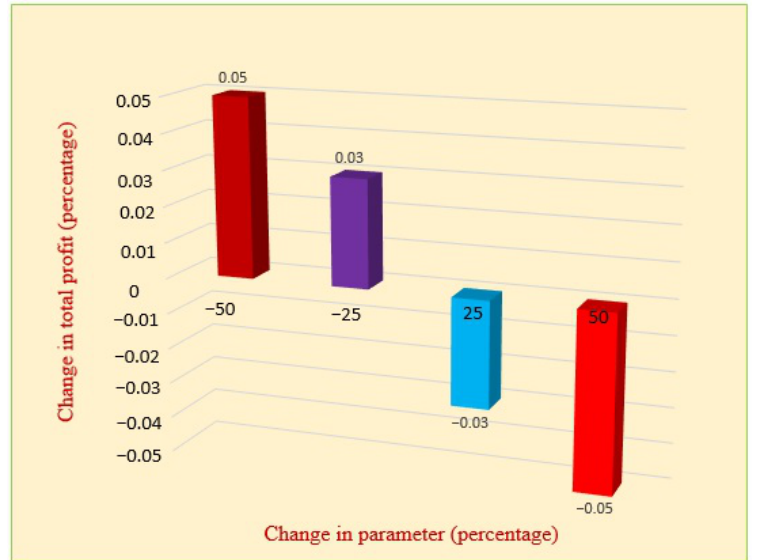
Figure 7. Effects of changes in parametric values versus total expected profit for the most sensitive parameter R o .